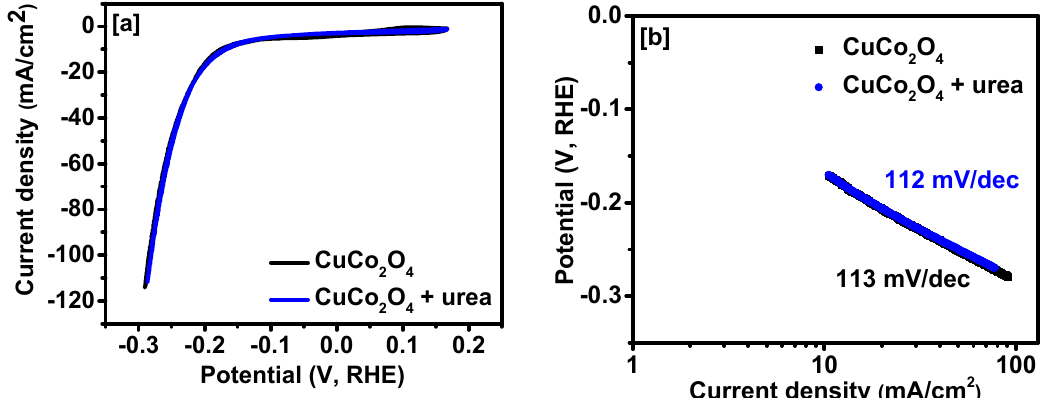
Figure 6. ( a ) Linear sweep voltammetry (LSV) curves of the CuCo 2 O 4 electrode toward HER in 1.0 M KOH with 0.33 M urea, and ( b ) corresponding Tafel plots.